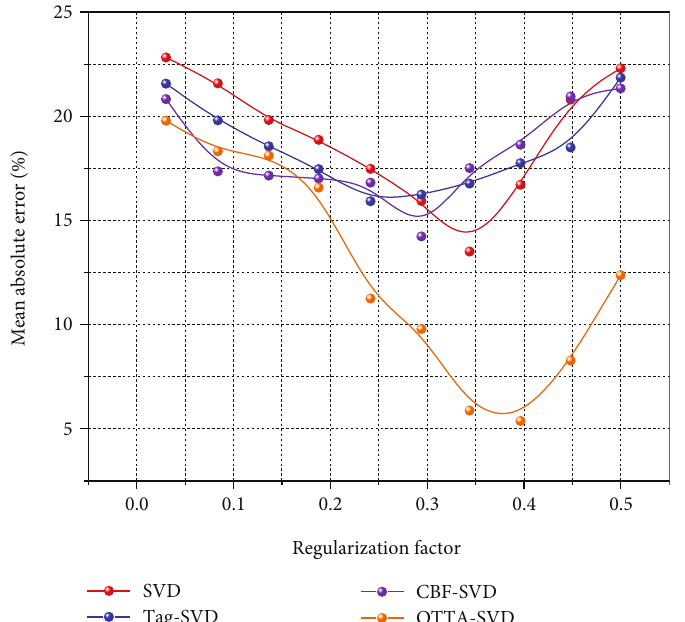
Figure 10: In fl uence of regularization coe ffi cient β on